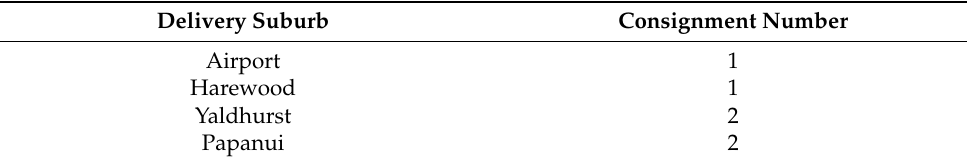
Table 5. Delivery suburbs with consignment numbers in DES